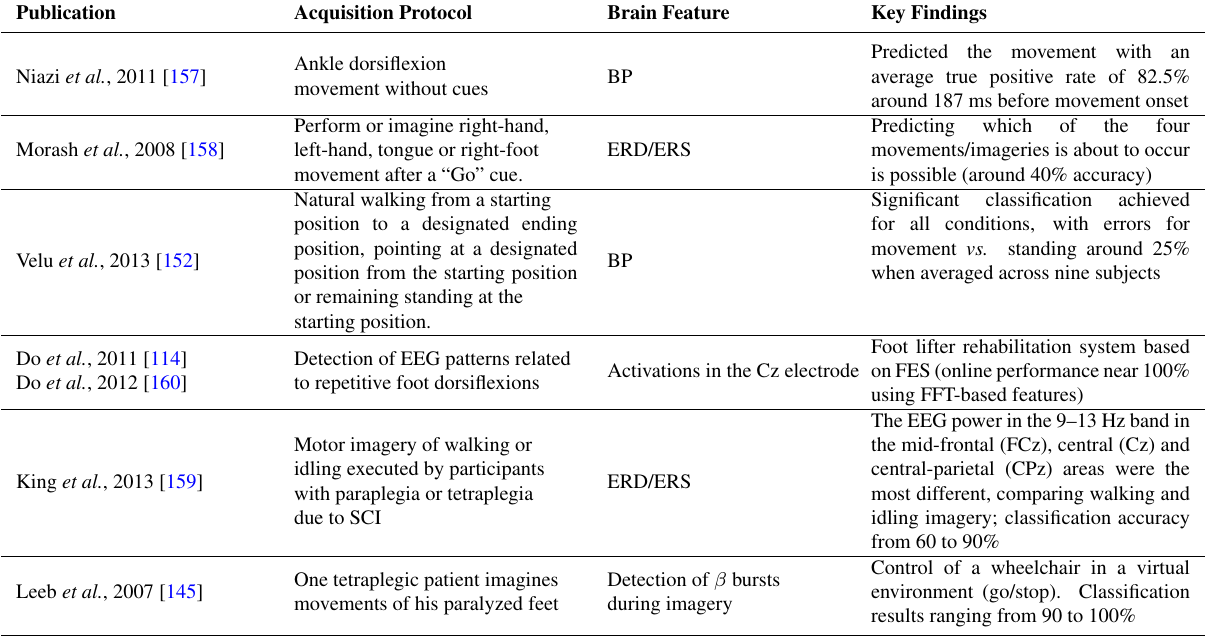
Table 5. Several studies of EEG signals preceding lower limb motor tasks are available. The presented results show that it should be feasible to activate a prosthetic/rehabilitation device. SCI, spinal cord